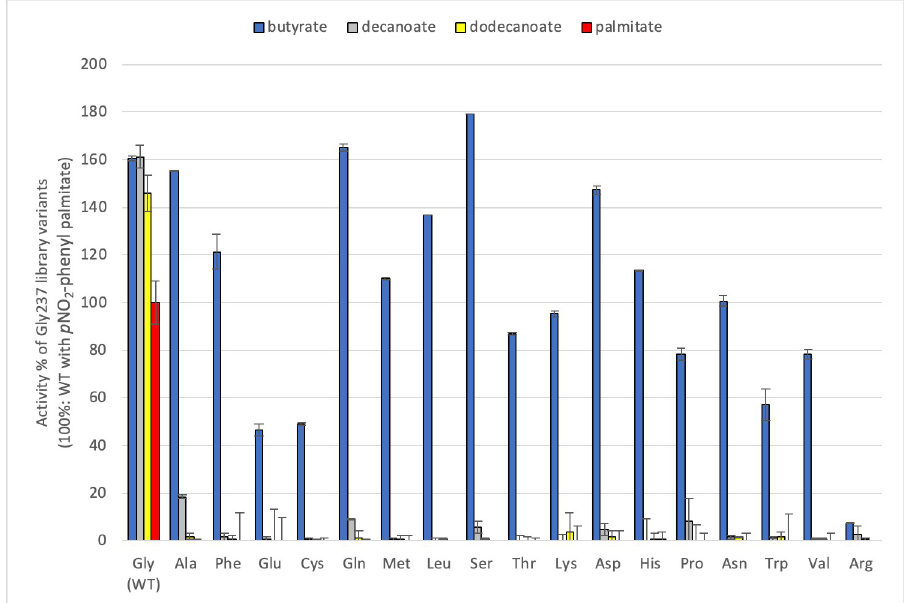
Fig 7. Hydrolytic activity of Gly237 variants with p -NO 2 -phenyl fatty acids. Assays were performed in triplicate with clarified E . coli lysates. Activity is reported relative to WT Cal-A with p NO 2 -phenyl-palmitate. Its specific activity (S.A) = 0.4 U/mg, is set as